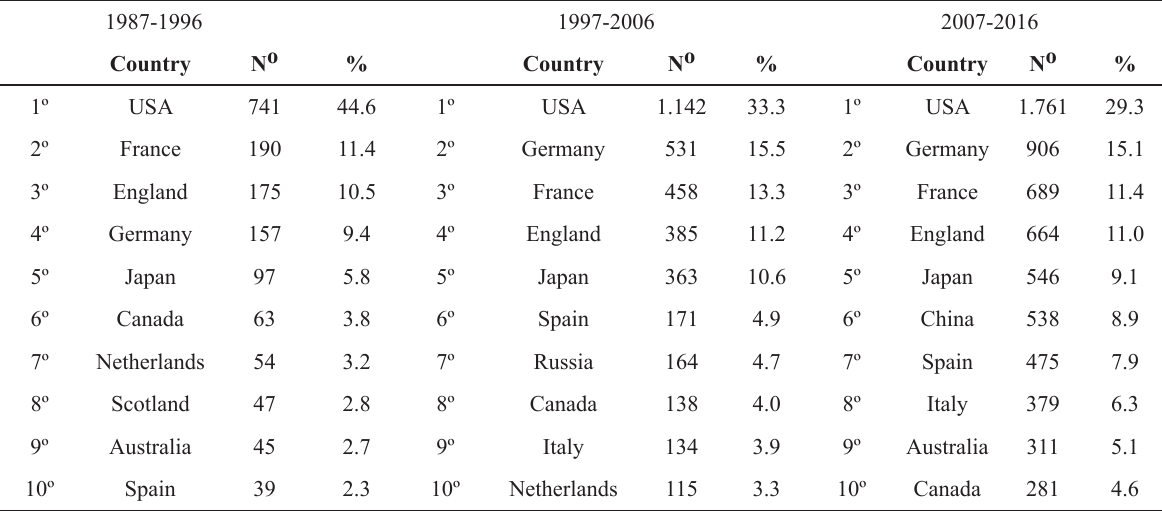
Total number and percentage of articles published by the 10 most productive countries in each decade between 1987 and 2016.